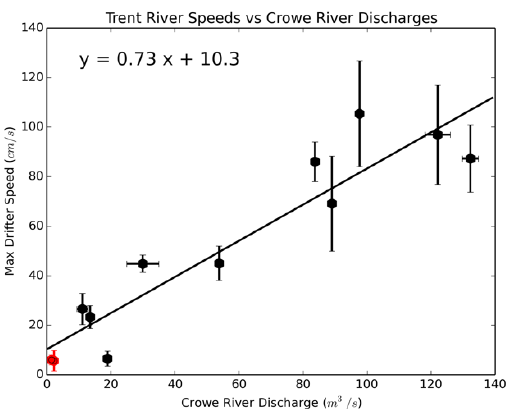
Figure 3. Average of observed drifters speeds (cm/s) in the fastest part of the river linearly regressed against Crowe River discharges (m 3 /s) (ECCC station 02HK002) as measured in 2017 – 2019. Cases where there was a flow reversal in the Trent River are marked in red.